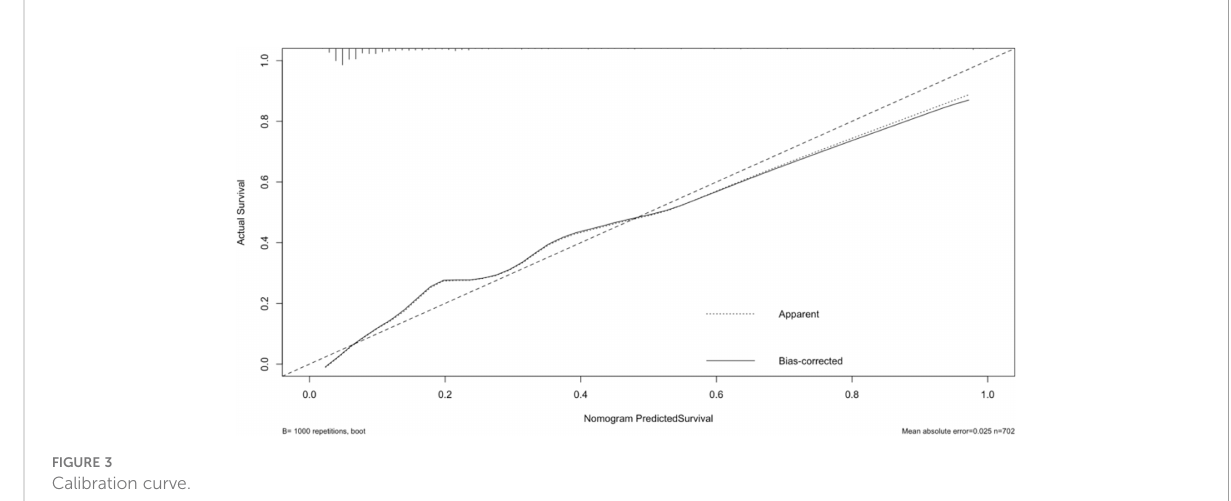
FIGURE 3 Calibration curve.